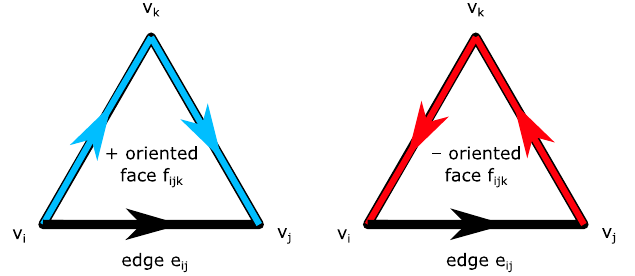
Figure 6. Directed network face orientation. Face orientation with respect to a given edge is determined by the direction of the corresponding edges in the face. In the same direction is positive (+) oriented, or feedforward; in the opposite direction is negative (−) oriented, or